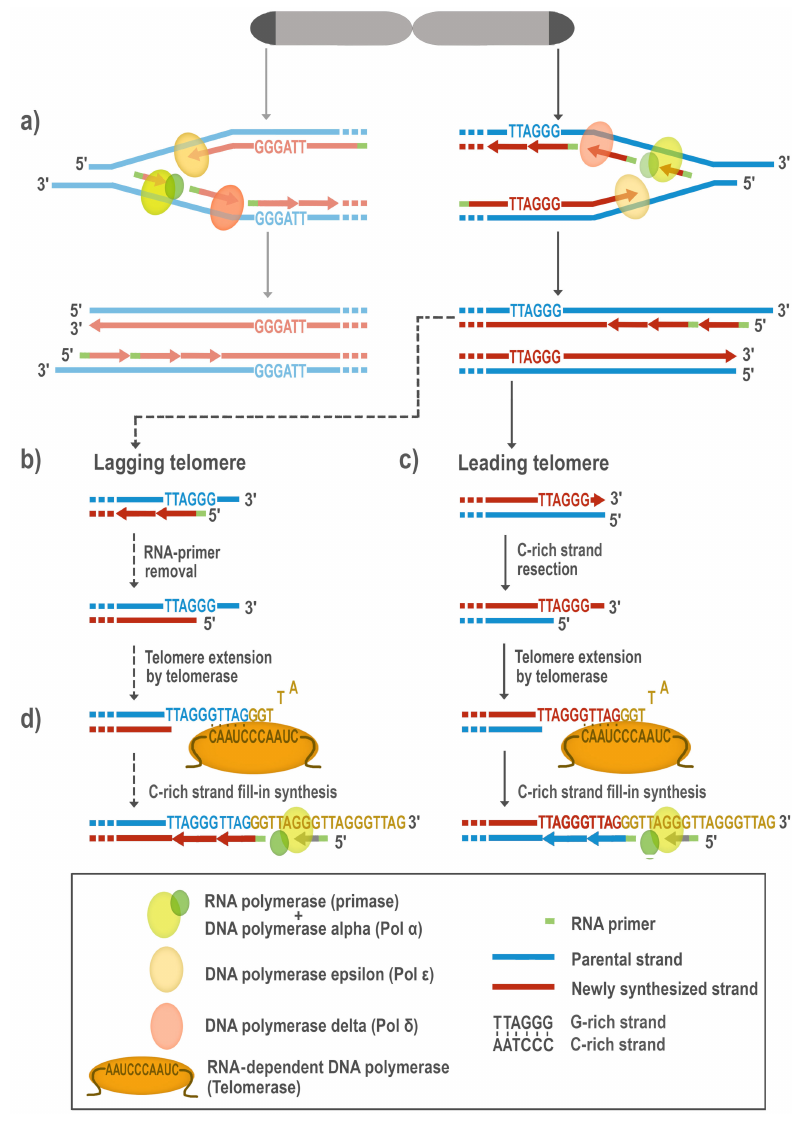
Figure 1. The replicating DNA in eukaryotes: DNA polymerases involved in replication. ( a ) During semiconservative DNA replication, each strand serves as a template for DNA polymerases to synthesize a new complementary strand. A specialized RNA polymerase (primase), that is a part of DNA Pol α , synthesizes the RNA primer. A single RNA primer aids DNA replication on the leading strand and multiple primers initiate Okazaki fragment synthesis on the lagging strand. Further DNA synthesis is carried out by DNA Pol ε and DNA Pol δ (reviewed in [4]). ( b ) The newly replicated telomere resulting from the lagging strand synthesis (Lagging telomere) retains the terminal RNA primer, which is subsequently removed. Attachment of the last RNA primer more proximally on the DNA strand, together with RNA-primer removal, creates an overhang on the G-rich strand. ( c ) The initial product of the leading strand DNA synthesis (Leading telomere) is a blunt terminus whose C-rich strand is then resected by an exonuclease to create the mature G-rich overhang. ( d ) In cells with an active RNA-dependent DNA polymerase (Telomerase), the G-rich overhangs, originating from Lagging or Leading telomeres, can undergo elongation (reviewed in [5]). Telomerase carries its own RNA molecule, which is used as a template, and can anneal through the first few nucleotides of its template region to the distal-most nucleotides of the G-rich overhang of the telomere DNA, add a new telomere repeat (GGTTAG) sequence, translocate, and then repeat the process. The complementary C-rich strand is then in-filled by DNA Pol α -primase